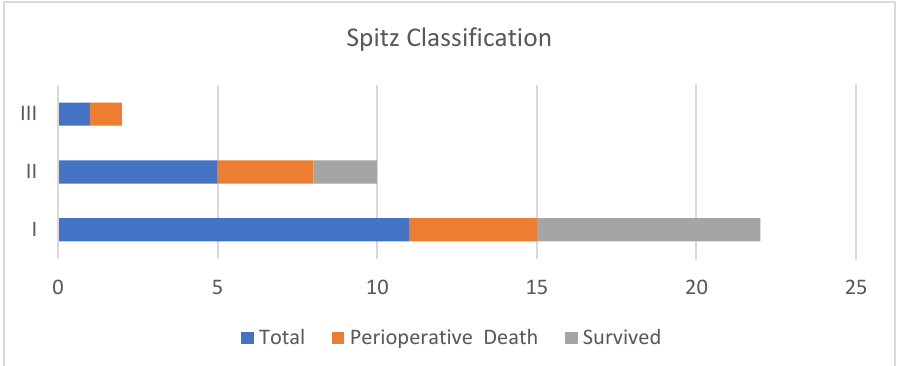
Figure 3. Spitz classification and outcome.